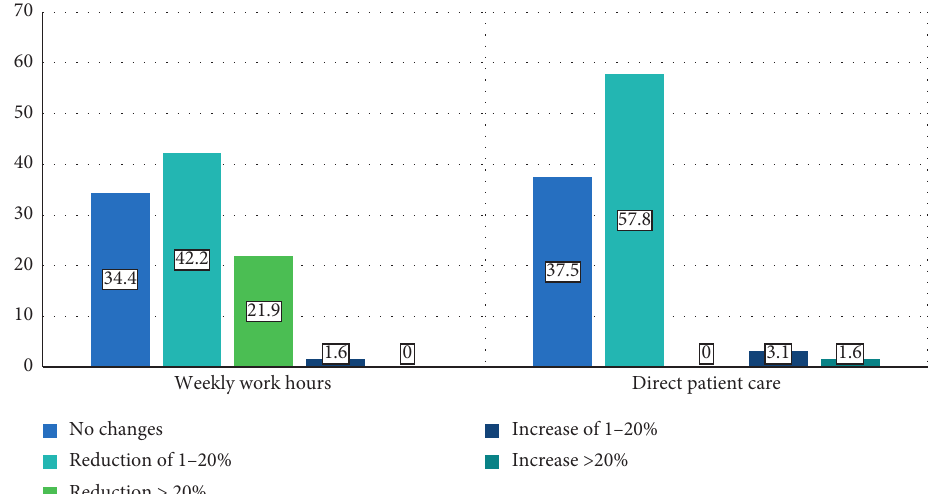
Figure 5: Desired changes in the clinical practice of Ecuadorian